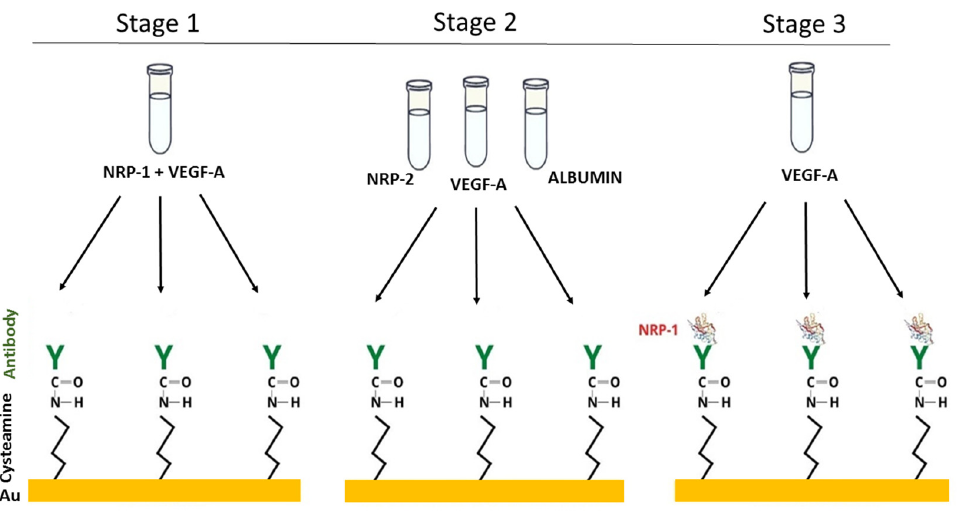
Figure 4. The experiment to test the selectivity of the biosensor.